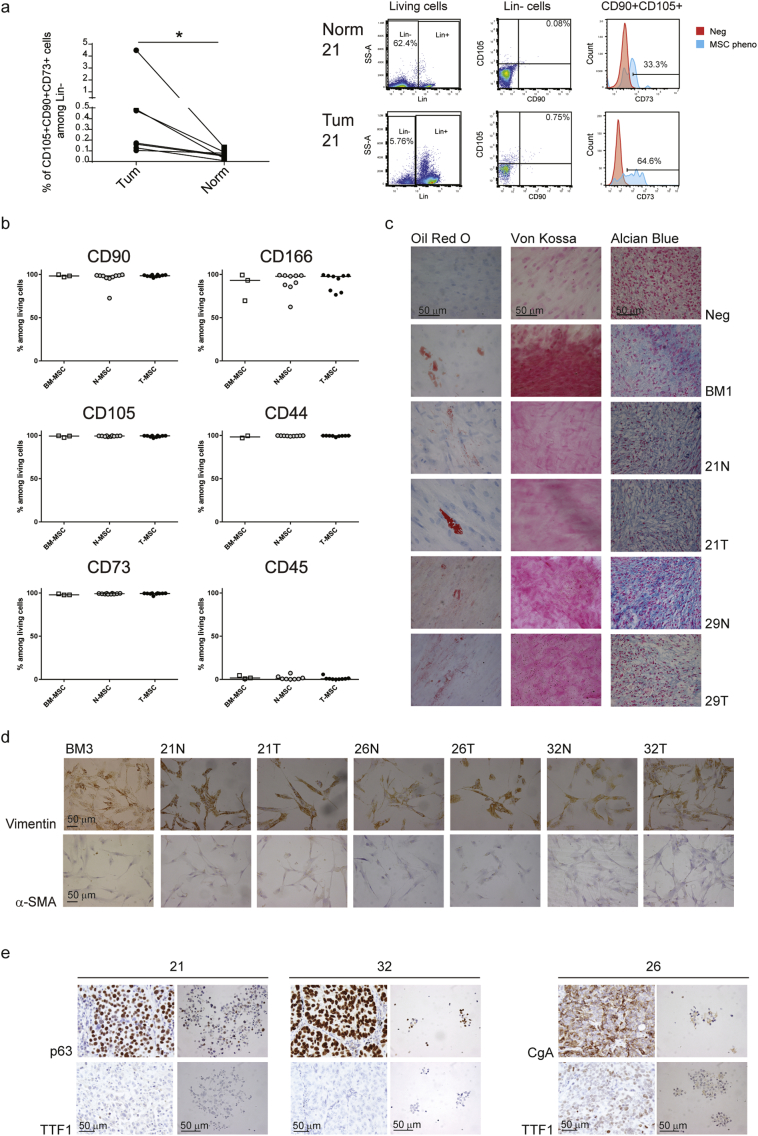
Primary MSC and tumor cell characterization.(A) On the left, proportions of MSC-like (CD105+CD90+CD73+) cells among Lin− cells (CD45−CD34−CD20−CD14−) in paired normal and tumor lung tissues (n = 7) assessed by flow cytometry after tissue dissociation. Statistical significance was determined by Wilcoxon matched-pairs signed rank test; P-value is indicated as * according to the level of significance (P < 0.05). On the right, dot plots and histograms from one representative patient (21) depicting the sequential gating strategy on living, Lin− and CD90+CD105+ cells for the assessment of MSC-like cell proportions in normal and tumor tissues. Percentages of Lin−, CD90 and CD105 double positive cells, and CD73+ cells among the parental population are reported. CD73 expression by CD90+CD105+ cells (blue) was calculated using unstained living cells as negative control (red). (B–D) In vitro characterization of MSC cell cultures: N- and T-MSCs from lung carcinoma patients (n = 10) were compared with BM-MSCs from healthy donors (n = 3). (B) The expression of MSC surface markers was calculated by flow cytometry and reported as percentages among living cells. Horizontal lines represent medians. (C) Differentiation potential into adipocytes (Oil Red O), osteocytes (Von Kossa) and chondrocytes (Alcian Blue) of MSCs from one representative donor (BM1) and patients 21 and 29. (D) Vimentin and alpha-SMA expressions were assessed immunohistochemically on BM3 and N- and T-MSCs from patient 21, 26 and 32. (E) Sphere-forming tumor cells (right pictures) from 21, 32 and 26 patients were characterized for the expression of tumor markers and compared with tumors of origin (left pictures). (C–E) Scale bar = 50 μm. See also Fig. S1.